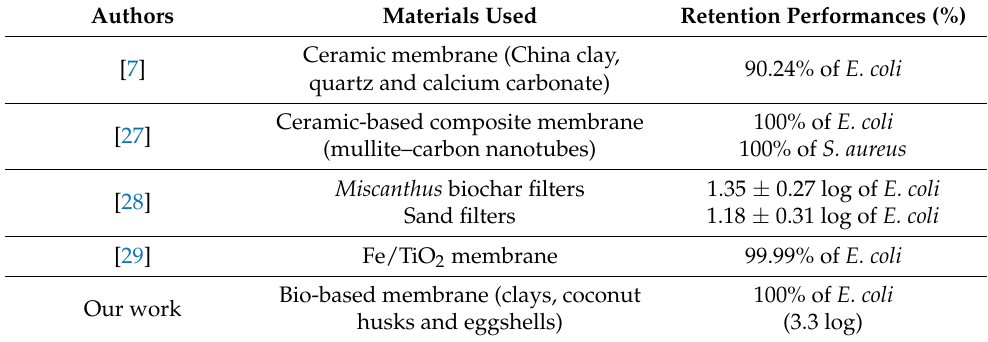
Table 4. Recent works reporting bacterial retention with ceramic membranes.